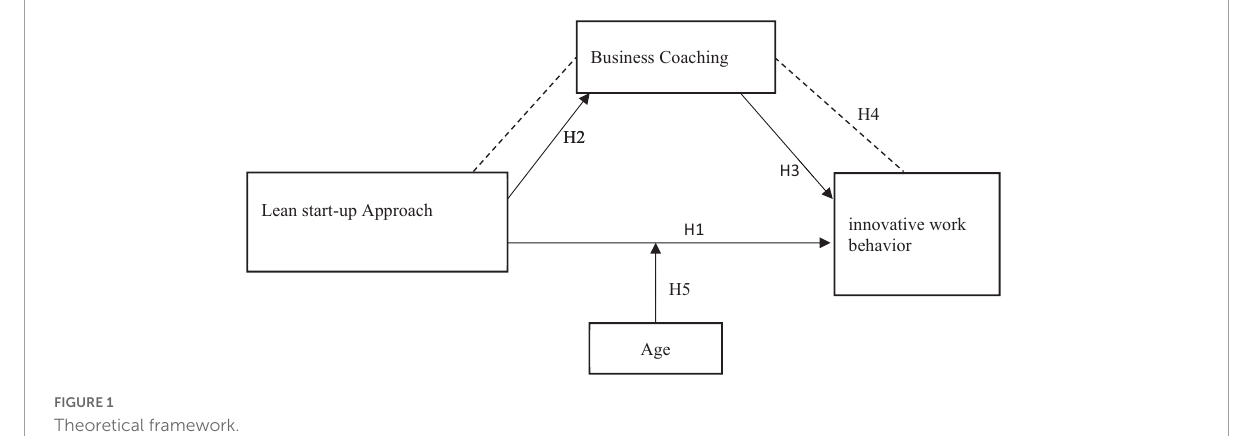
FIGURE1 Theoretical framework.